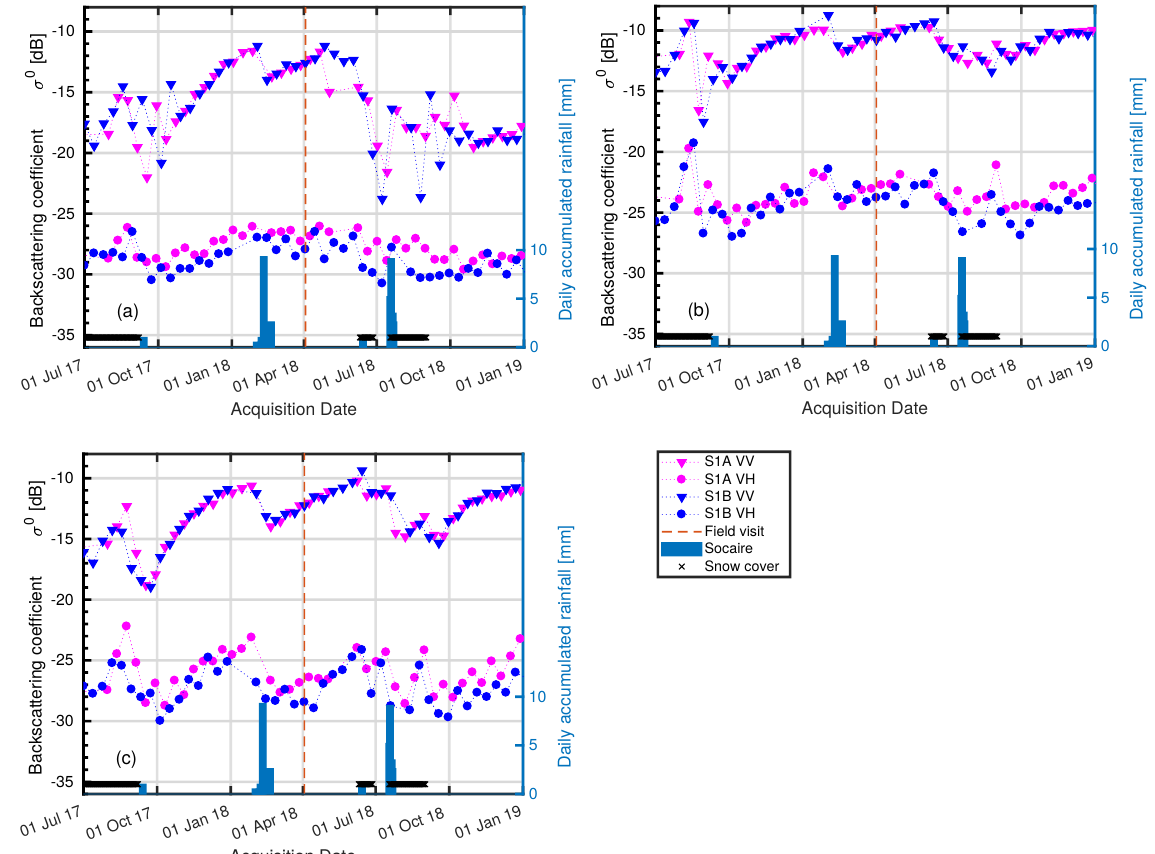
Figure 4. Sentinel 1 temporal backscattering observed over the salar. Sentinel 1A (magenta) and Sentinel 1B (blue) in ascending passes. VV polarization is indicated as triangles, and VH as circles. The vertical dashed line indicates field visit on April 3, 2018 (see Figure 2). (a) Soft pan crust (site S1), the local incidence angle is between 35.2°-35.4°; (b) Type 2 hard pan crust (S6), the local incidence angle is between 39.9°-40.1°; (c) Type 1 hard pan crust (S10), local incidence angle is between 39.2°-39.3°. Accumulated rainfall measured by Socaire station is shown as bars and snow occurrence is indicated as cross marks above the